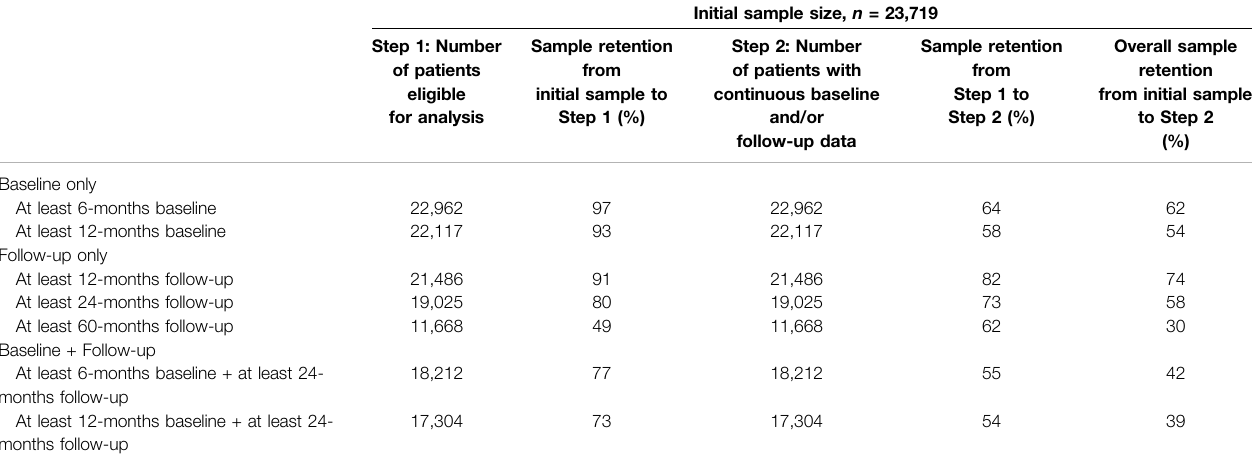
TABLE 6 | Sample attrition and data continuity among patients with type 2 diabetes mellitus in the National Cheng Kung University Hospital electronic health record